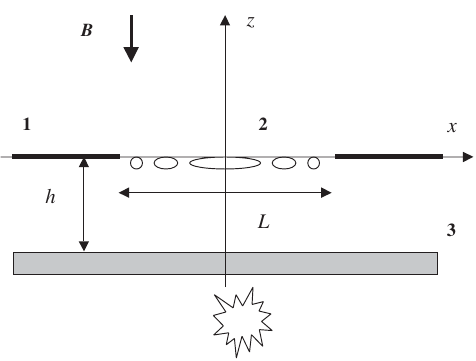
Fig. 1. The model used to calculate the depression of the ULF geomagnetic pulsations: 1 – conducting ionosphere; 2 – ionospheric inhomogeneities; 3 – Earth surface. h is the height of the lower boundary of the ionosphere; L is the spatial scale of the seismic